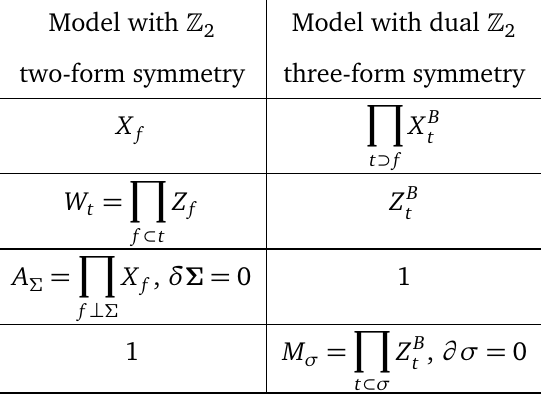
on all edges intersecting with a closed e three-form symmetry, generated by membrane oper- 2 Model with (cid:90) Model with dual (cid:90) 2 2 two-form symmetry three-form symmetry (cid:89) X X B f t t ⊃ f (cid:89) = W Z Z B t f t f ⊂ t (cid:89) A Σ = X , δ Σ = 0 1 f f ⊥ Σ (cid:89) Z B , ∂ σ = 1 M σ = t t ⊂ σ